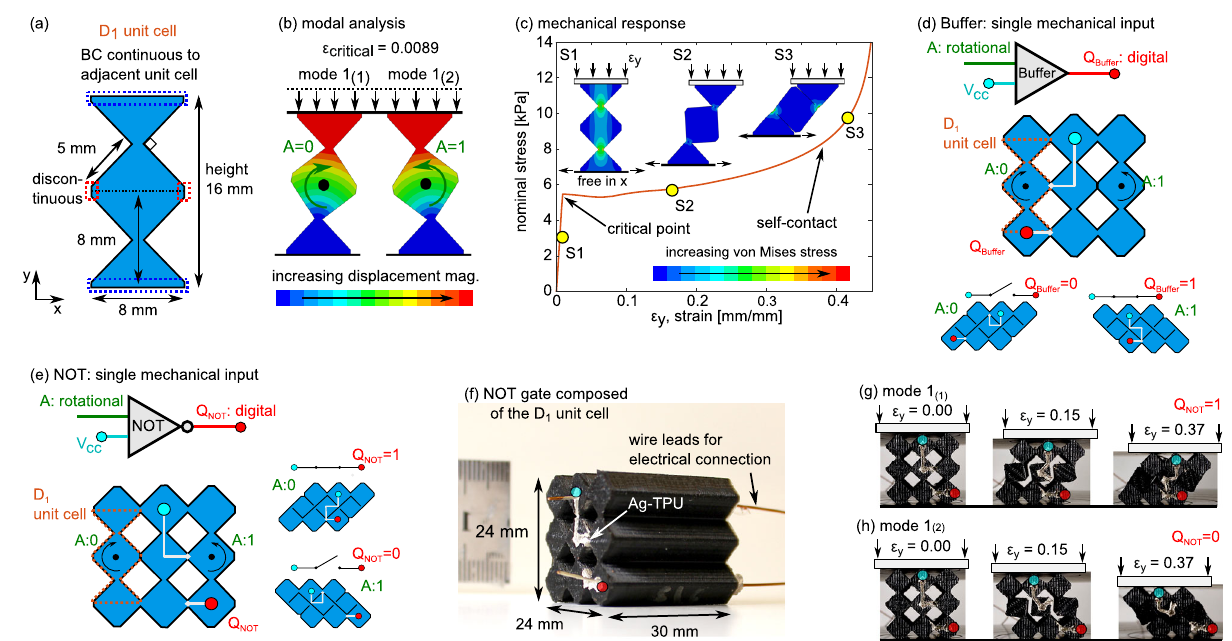
Fig. 3 Bit abstraction via buckling direction. a D 1 unit cell dimensions with boundary conditions. b Modal analysis of D 1 unit cell with two deformation states, mode 1 (1) and mode 1 (2) . c Simulated mechanical response of D 1 unit cell featuring three deformation regimes. d Schematic of Buffer gate as direct electrical switch governed by a single mechanical rotation input, corresponding to the buckling mode. e Schematic and ( f ) experimental image of the NOT gate with one mechanical input rotation (green) and one digital output terminal (red) Q NOT on the metamaterial composed of D 1 unit cells. The powered input terminal is the cyan node, V cc . Photos of the NOT gate under uniaxial compression as it exhibits buckling ( g ) mode 1 (1) and ( h ) mode 1 (2) , along with the corresponding digital outputs Q NOT (red